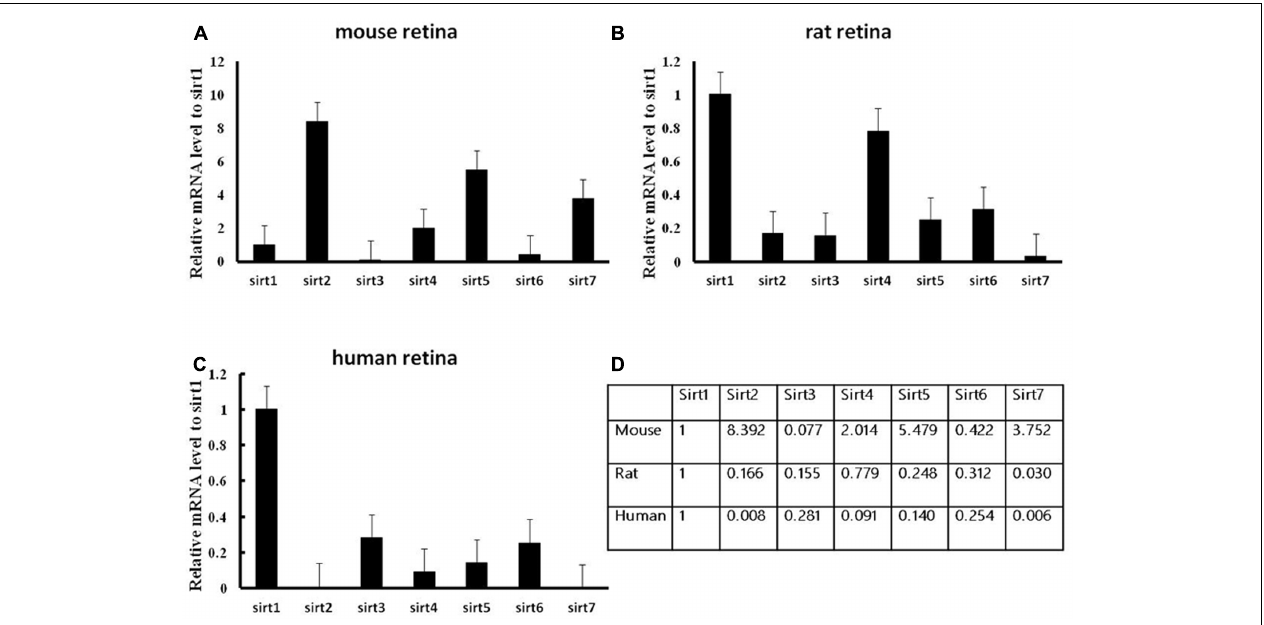
FIGURE 1 | Expression of Sirtuin (SIRT1-7) genes in adult mouse, rat, and human retinal neurons. Histograms showing the SIRT1-7 mRNA levels in the retinas of mice (A) , rats (B) , and humans (C) as determined by qRT-PCR. The y -axis shows the Sirtuin expression levels relative to the SIRT1 gene. Data shown are based on the linear conversion of delta CT values for each sample ( n = 5); error bars denote SEM. Statistical comparisons between the retinal expression levels of the different Sirtuins in each species are presented as a table (D)